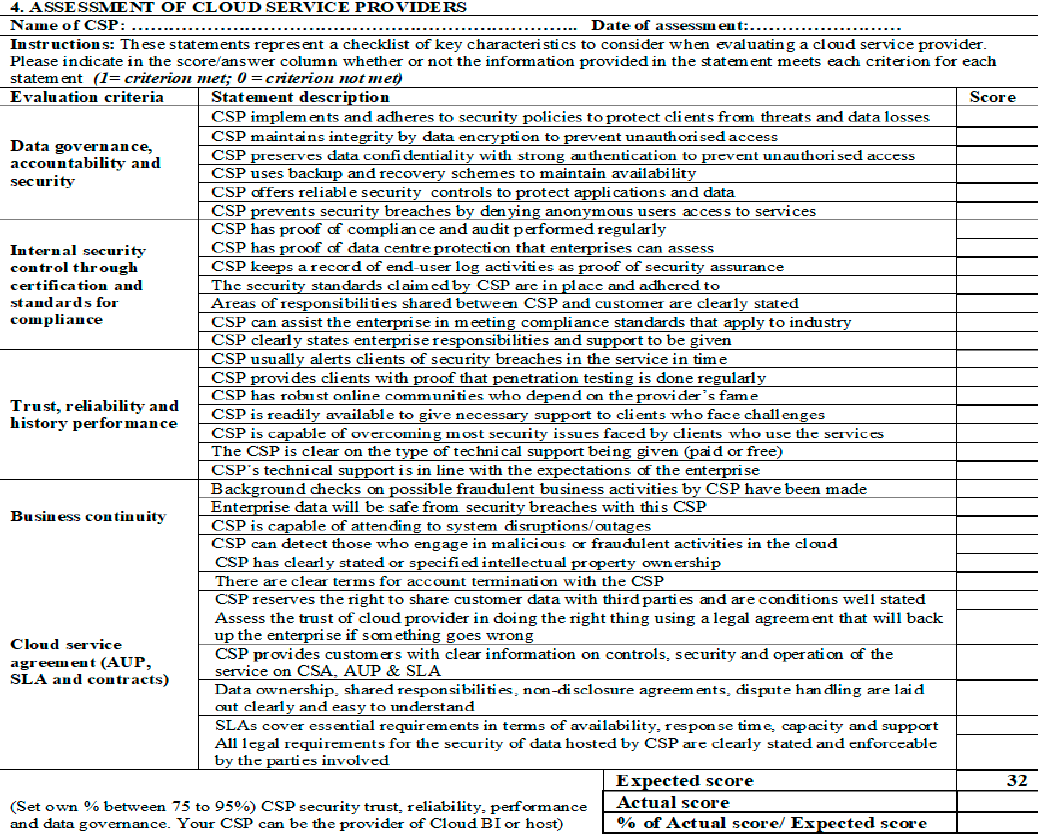
Figure 11. Checklist for assessing CSP security, reliability, and performance.